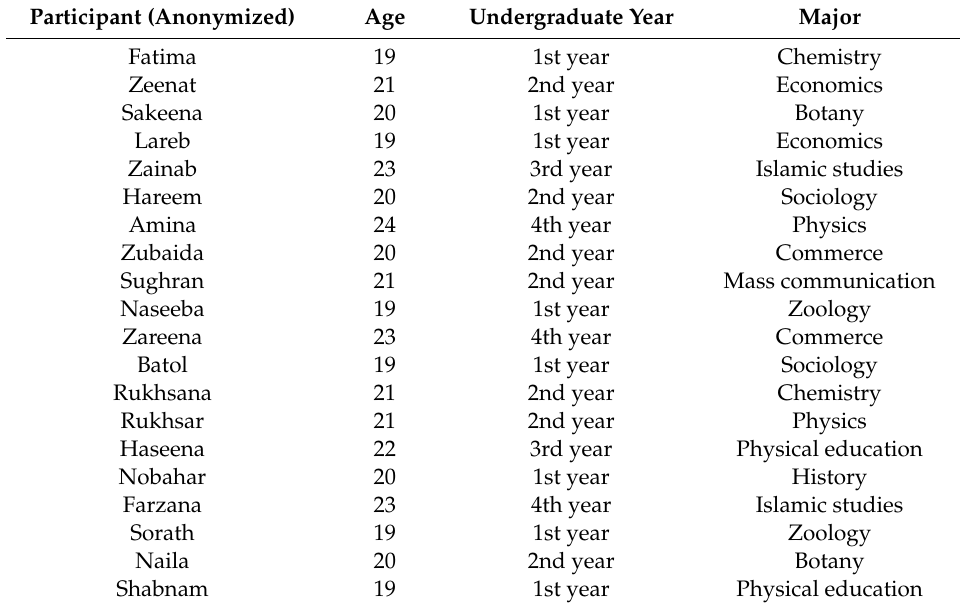
Table 1. Background information of